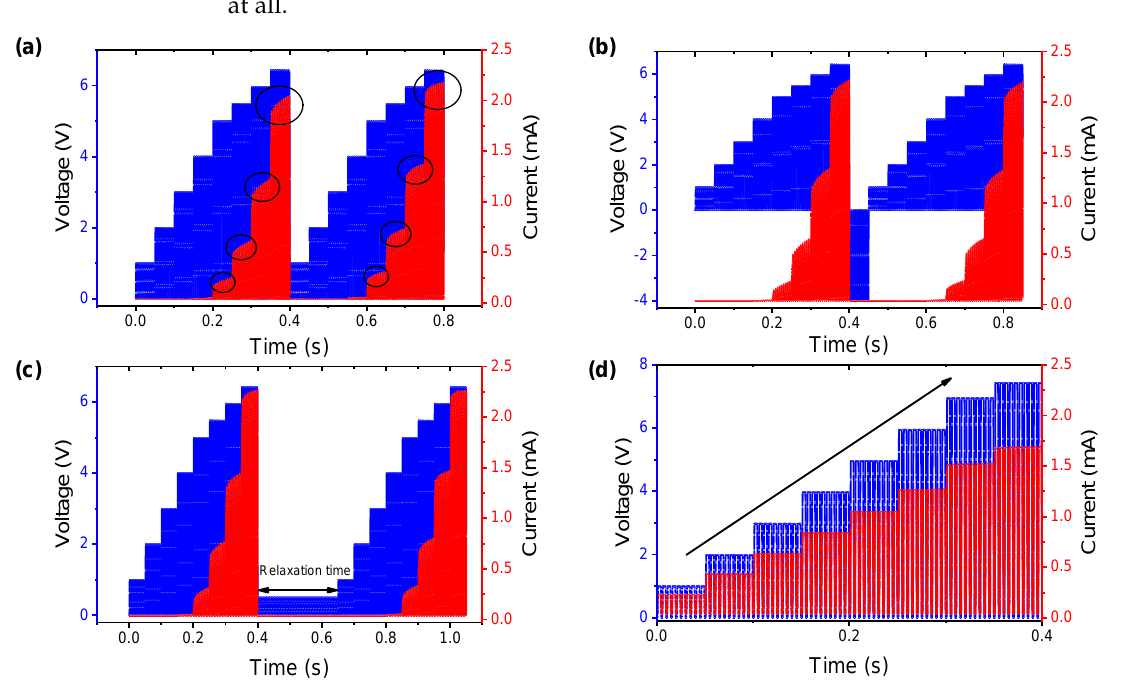
Figure 6. Current response with stair-shaped voltage in PTT. ( a ) Different amplitudes (1 V, 2 V, 3 V, 4 V, 5 V, 5.5 V, 6 V, and 6.5 V) are applied with a pulse width of 3 ms. ( b ) Negative voltage (−4 V) is applied between stepped pulses. ( c ) Sufficiently long relaxation time of 160 µs and 0.5 V amplitude is applied between stepped pulses so as to not affect the current response. ( d ) Voltage (1 V, 2 V, 3 V, 4 V, 5 V, 6 V, 7 V, and 7.5 V) is applied in PTT that does not function as a nociceptor memristor.